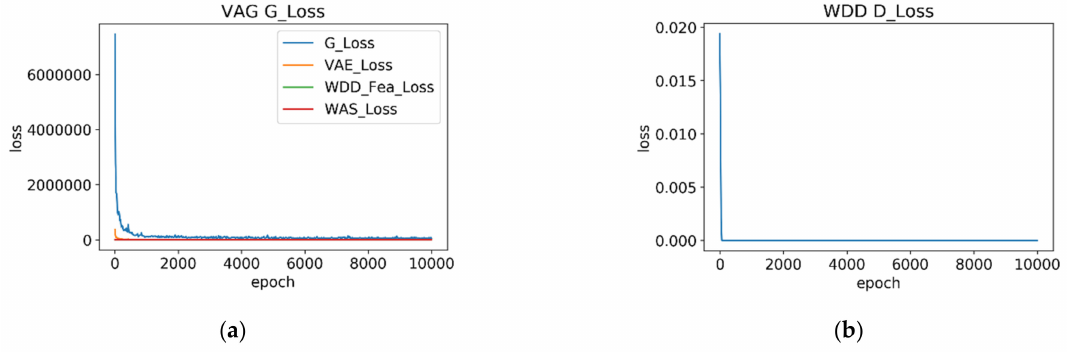
Figure 3. The training loss curve at every 20 epochs over 10,000 epochs of the VAG model with WDD. ( a ) the VAG G_loss curve; ( b ) the WDD D_Loss